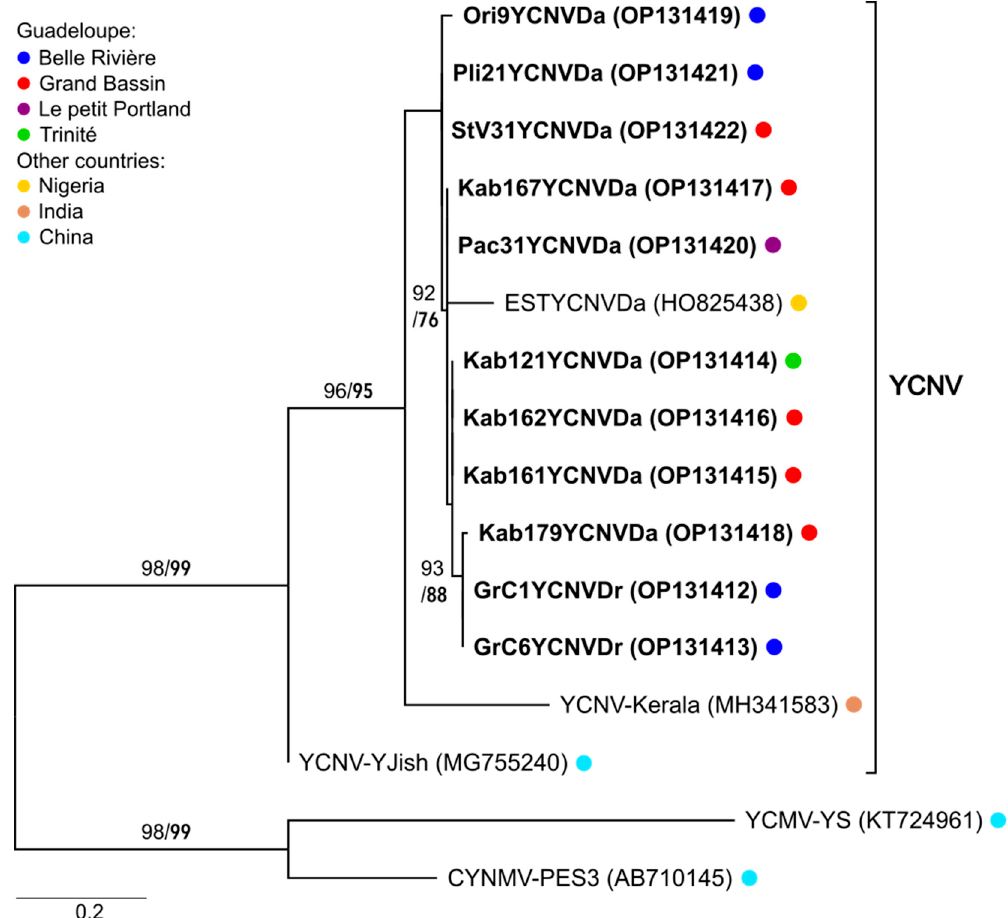
Figure 4. Maximum Likelihood phylogenetic tree showing the relationships between the sequences obtained in this study (in bold) and those of previously characterised YCNV isolates. Phylogenetic analyses were performed on the coding part (131 nt) of amplified sequences corresponding to nucleotide positions 7903–8033 in the genome of YCNV-YJish. An arbitrary root was positioned at the branch separating YCNV from other macluraviruses infecting yam (yam chlorotic mosaic virus and Chinese yam necrotic mosaic virus). The key to the coloured dots referring to the location of the samples from which sequences originate is shown in the box on the left of the figure. Numbers above the branches show SH-aLRT (in normal font) and UFBoot (in bold) give the branch support values expressed in percent of the sampled